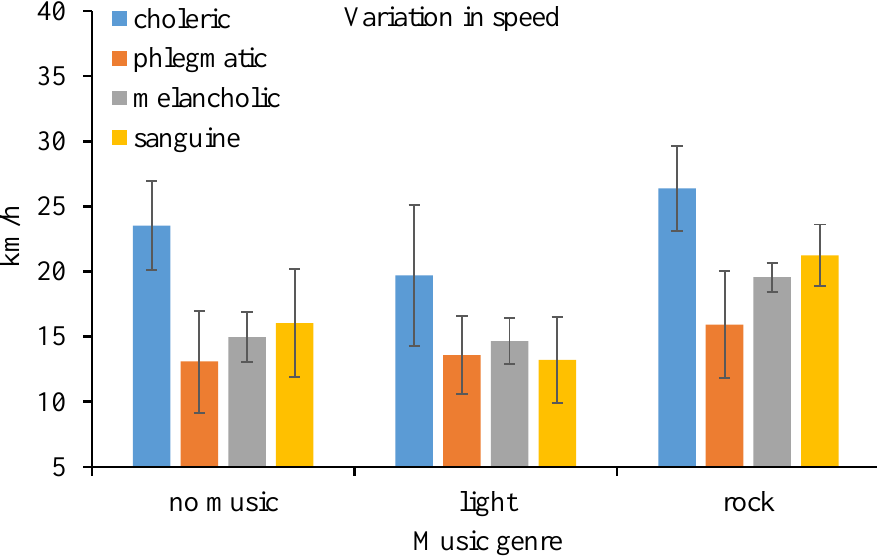
Figure 5. Variation in speed (and standard error) by music genre and personality.